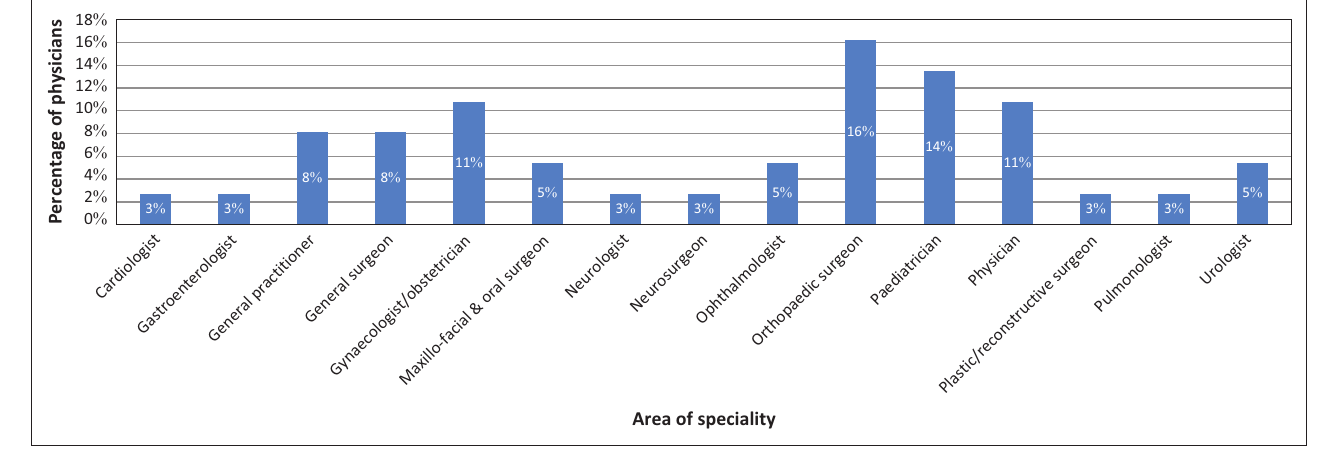
FIGURE 1: Participant speciality.